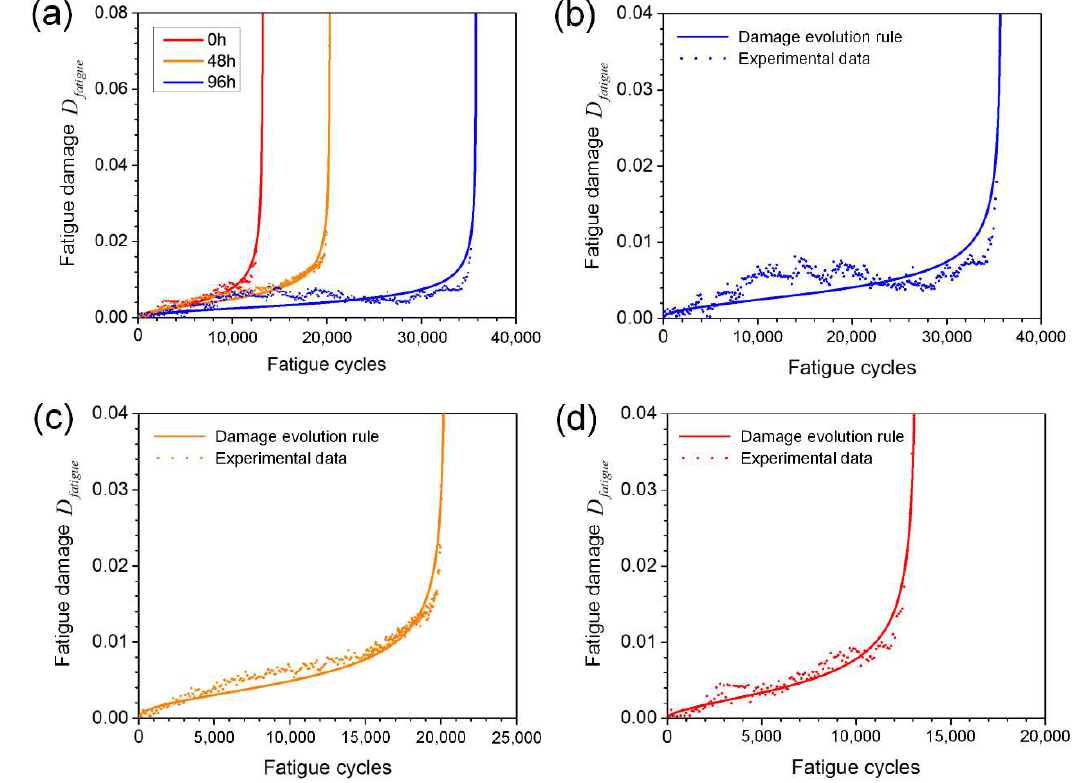
Figure 6. Measured and fitted damage curves during fatigue tests for specimens with different corrosion times ( a ) 0, 48 and 96 h, ( b ) 0 h, ( c ) 48 h, ( d ) 96